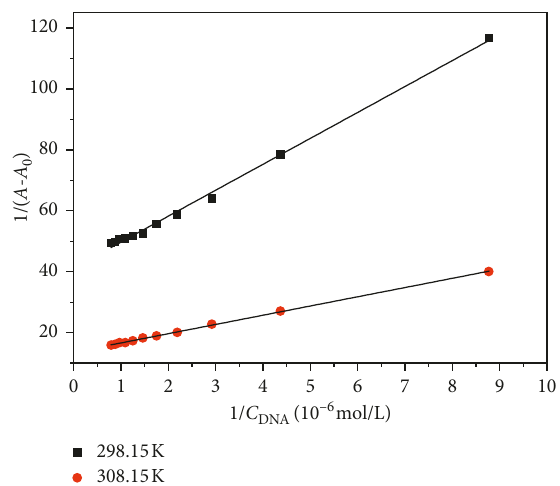
Figure 5: Double reciprocal plots of DNA-thulium(III)-arsenazo III system (pH 7.40; λ